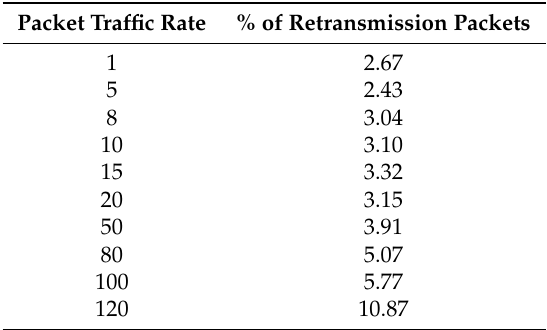
Table 4. Retransmission